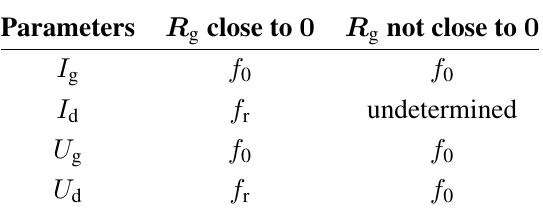
Table 1. The analyzed main frequency of the short-circuit current and voltage.